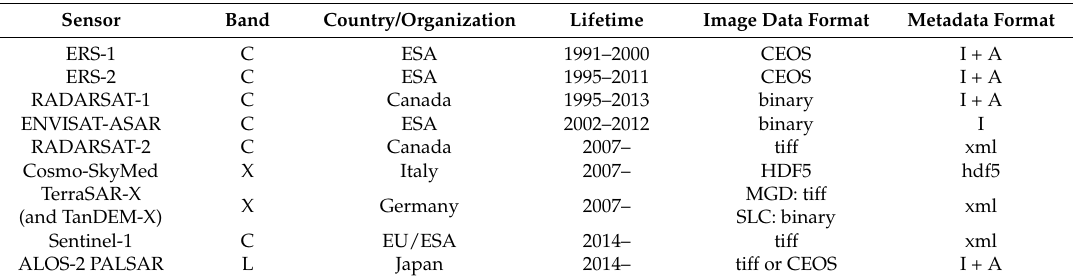
Table 1. Satellite SARs that can be processed by SUMO. In the last column, “I” means that the metadata resides inside the image data file; “I + A” means that the metadata is partly inside the image data file and partly in one or more auxiliary files. In the “Lifetime” column, no end date means that the sensor was still operational at the time of writing. In the “Image data format” column, CEOS refers to the SAR data products format standard of the Committee on Earth Observation Satellites (ceos.org) and HDF5 is Hierarchical Data Format 5 of the HDF Group